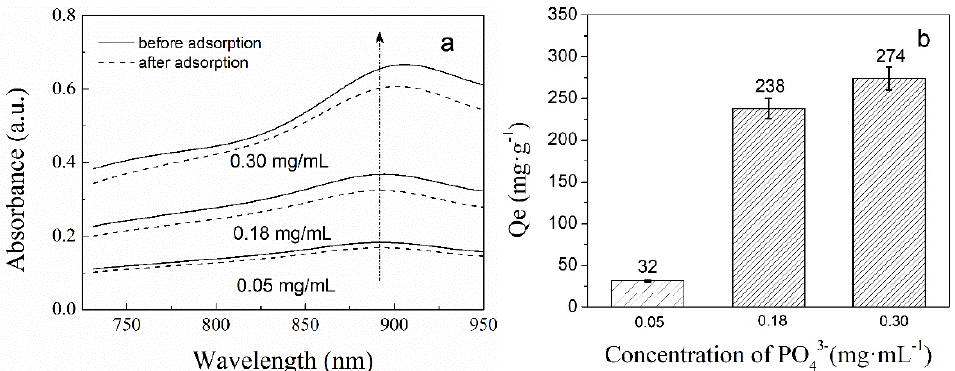
Figure 8. The UV-vis absorption spectra of phosphate solutions before and after adsorption at different initial concentrations of phosphate solutions ( a ) and the final adsorption capacity with various initial phosphate concentrations ( b ).